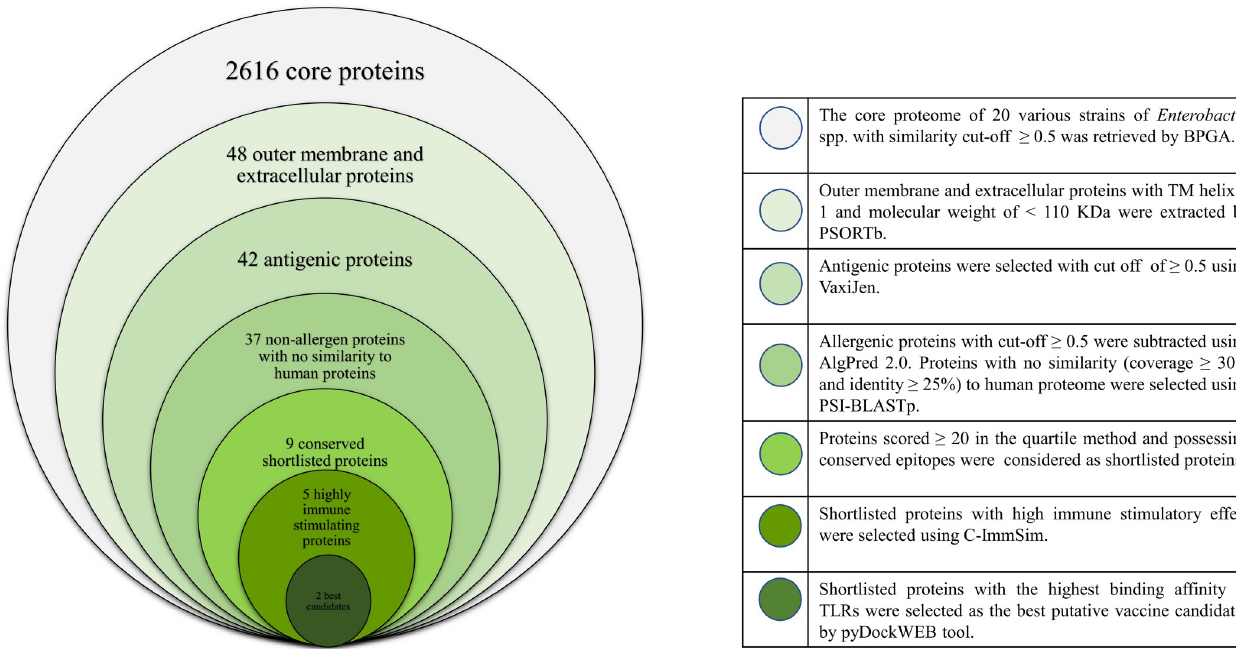
Fig 3. The workflow used for the identification of putative immunogenic candidates against E . cloacae complex.